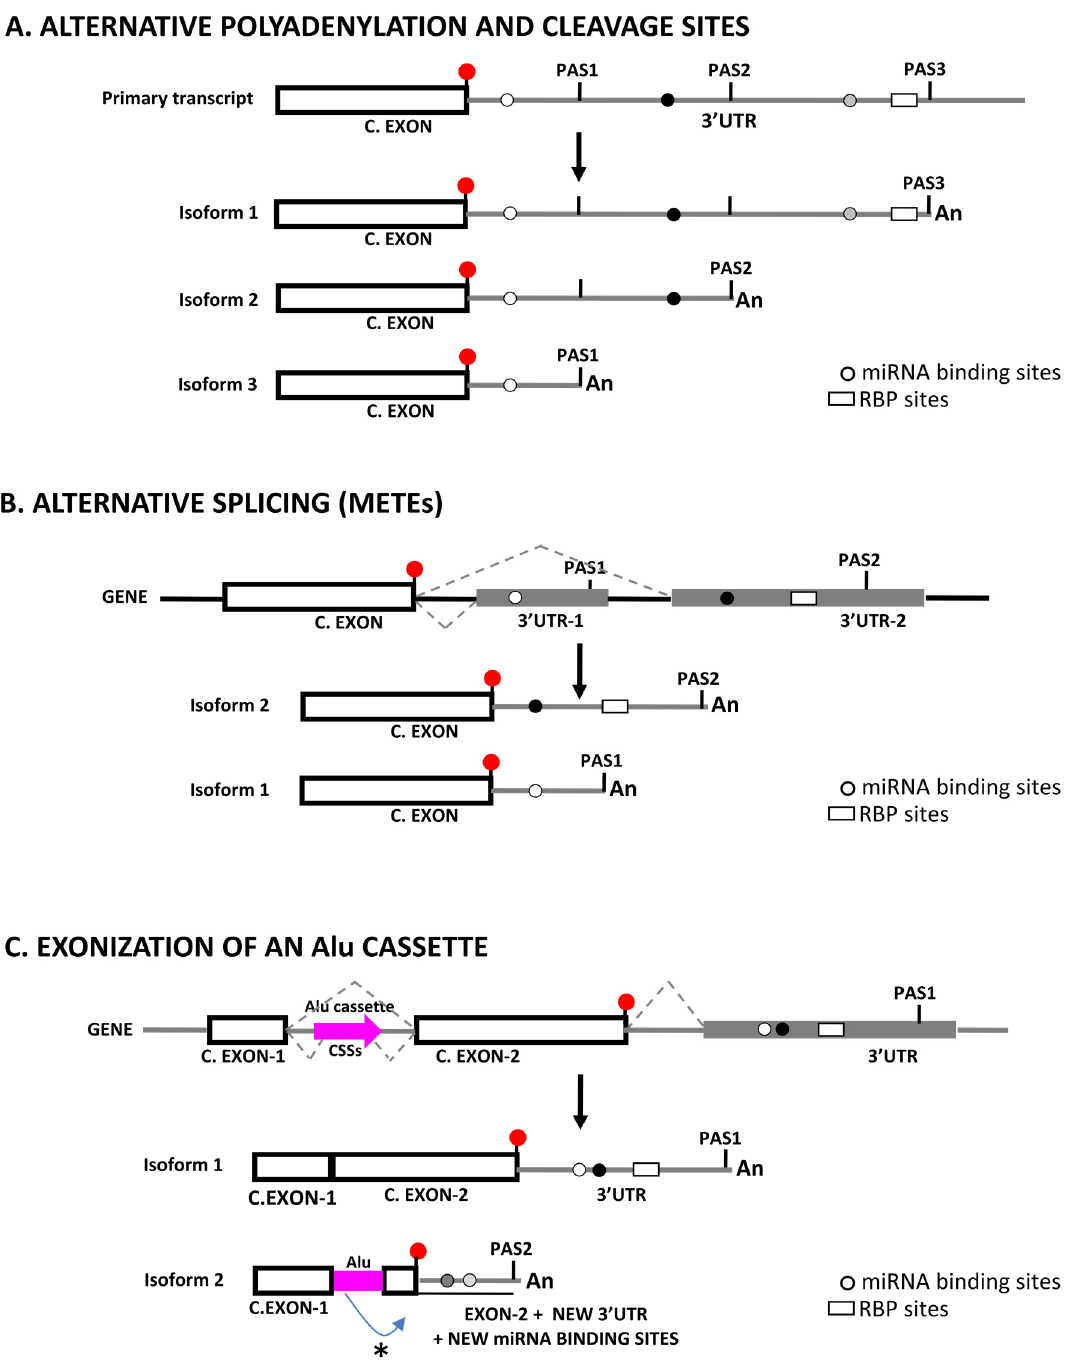
Figure 1. Original drawing showing three mechanisms that generate sequence length variability at 3 (cid:48) UTRs and their potential impact on the regulatory landscape by miRNAs and RBPs. Other mechanisms, or combinations among those displayed are not shown. In all cases C.EXON stands for Coding Exon. ( A ) Use of alternative polyadenylation and cleavage sites. Diagram representing the generation of three different transcript isoforms from a primary transcript by the use of three different polyadenylation and cleavage sites (PAS1, PAS2, PAS3), and how this changes the regulatory landscape. Shown is a terminal coding exon with its stop codon (red dot), as well as the 3 (cid:48) UTRs (gray lines) with the different PAS, miRNA binding sites (gray dots), and a RBP site (white box). [An] stands for the poly-A tail. ( B ) Use of alternative splicing sites: Mutually Exclusive Terminal Exons (METES). Diagram representing the generation of two different transcript isoforms from a single gene by the use of two mutually exclusive 3 (cid:48) UTR terminal exons, and how this changes the regulatory landscape. Shown is a terminal coding exon with its stop codon (red dot), as well as the 3 (cid:48) UTRs (gray boxes/lines) with the